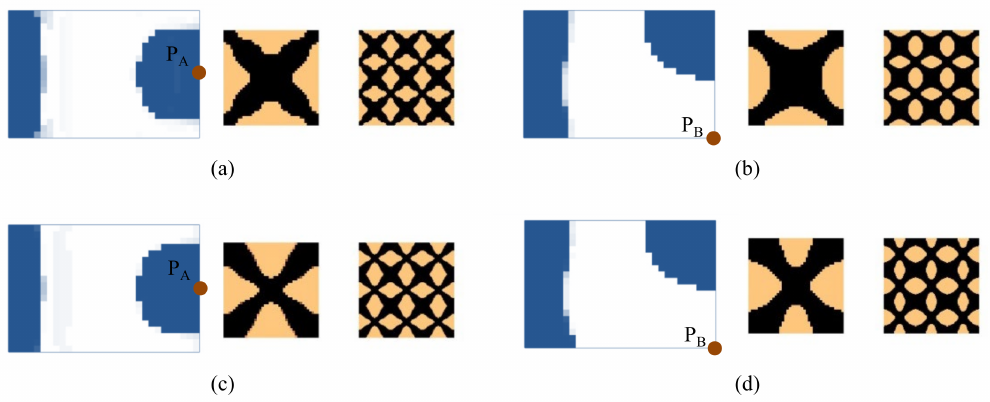
Figure 9. Design results with different initial guesses and exciting positions. The excitation frequency range is 90–200 Hz. ( a ) Initial guess 1, excitation position P A . Dynamic compliance 1.720 N · mm. ( b ) Initial guess 1, excitation position P B . Dynamic compliance 3.207 N · mm. ( c ) Initial guess 2, excitation position P A . Dynamic compliance 1.724 N · mm. ( d ) Initial guess 2, excitation position P B . Dynamic compliance 3.211 N ·